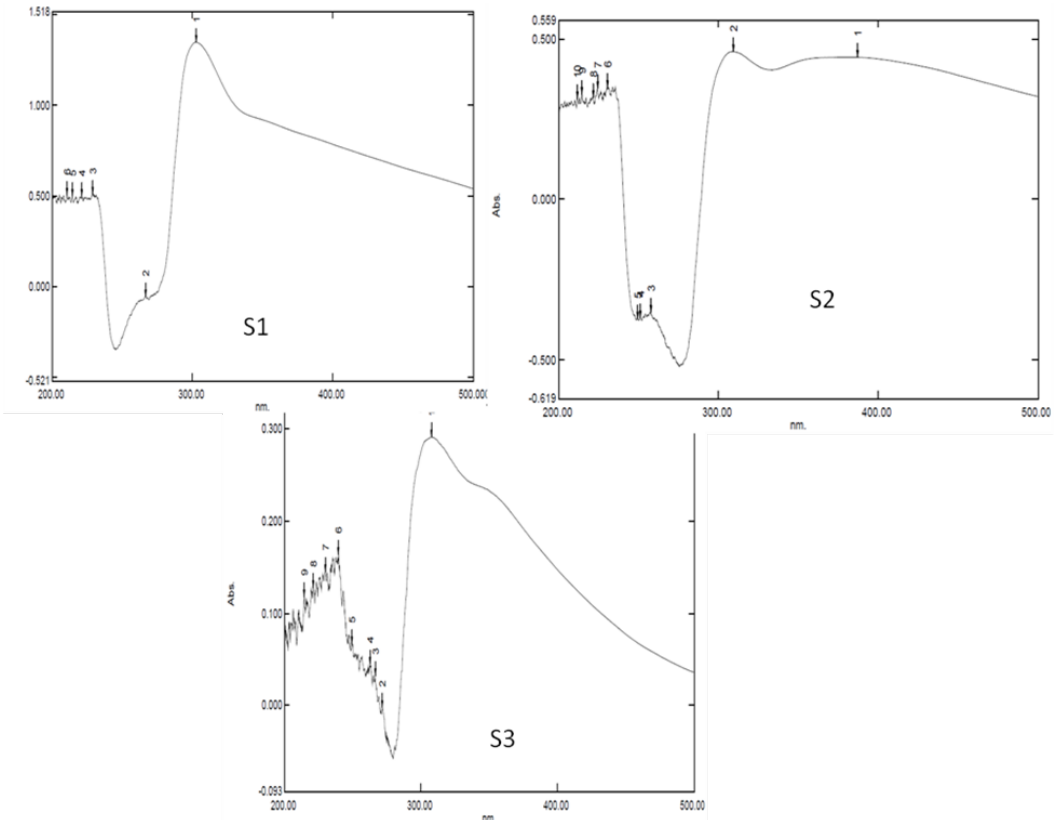
Fig. 2 UV-vis spectrum of silver nanoparticle produced by Escherichia coli using S 1 (10 mml culture supernatant + 40mg/ml of silver nitrate), S 2 (20 ml culture supernatant + 30mg/ml of silver nitrate) and S 3 (30 ml culture supernatant + 20mg/ml of silver nitrate) Fig. 2. UV-vis spectrum of silver nanoparticle produced by Escherichia coli using S1 (10 ml culture supernatant + 40mg/ml of silver nitrate), S2 (20 ml culture supernatant + 30mg/ml of silver nitrate) and S3 (30 ml culture supernatant + 20mg/ml of silver